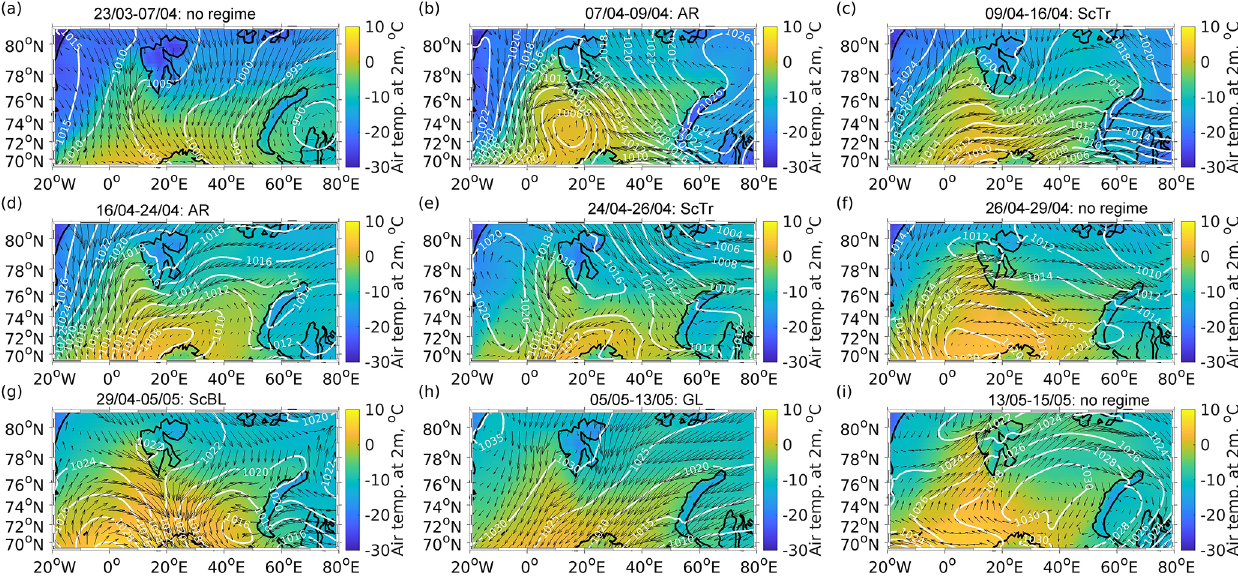
Figure 8. Synoptic-scale meteorological conditions in ERA5 reanalysis data for the nine sub-periods. The colour scale and the white contour lines show air temperature at 2m height and mean sea level pressure, respectively. The black arrows represent the prevailing wind direction and show the length relative to the wind speed. They are plotted with a resolution of 2 ◦ longitude and 1 ◦ latitude.